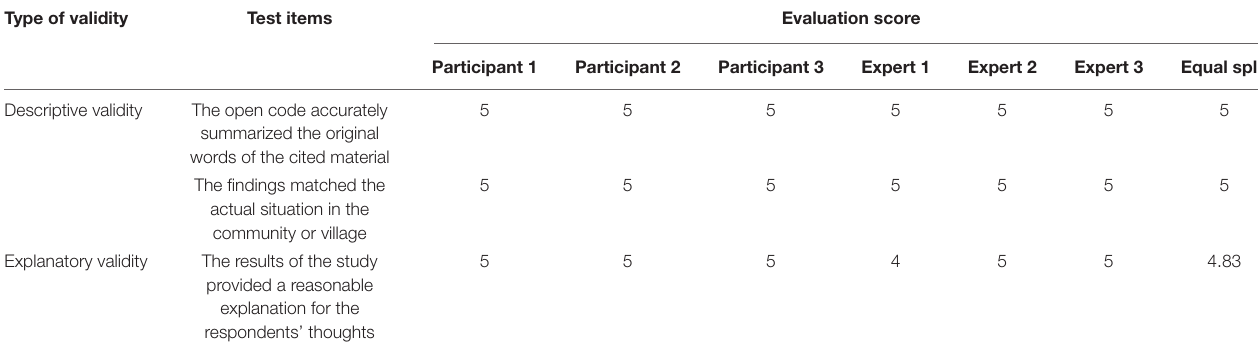
TABLE 2 | Results of evaluative reading assessment.